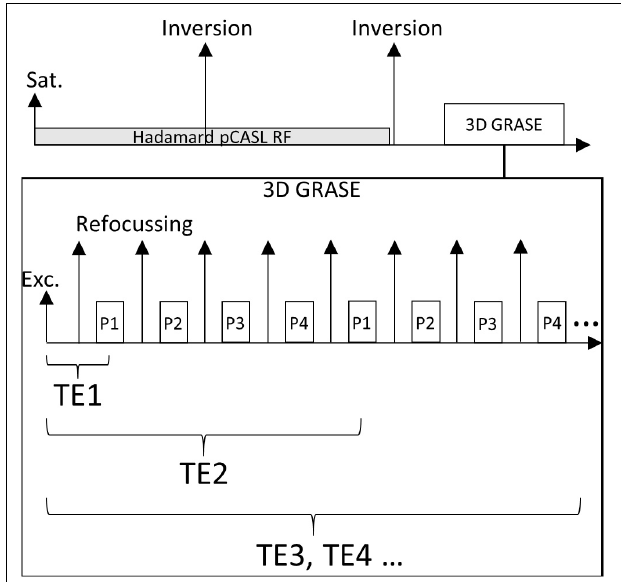
FIGURE 2 | A schematic diagram of the Hadamard multi-TE ASL sequence. After presaturation, two inversion pulses are played out during the Hadamard labelling train and the post-labelling delay for background suppression. Using 3D GRASE, multiple k-space partitions as well as echo times are acquired after a single excitation. Here, an example using four partitions (P1–P4) is